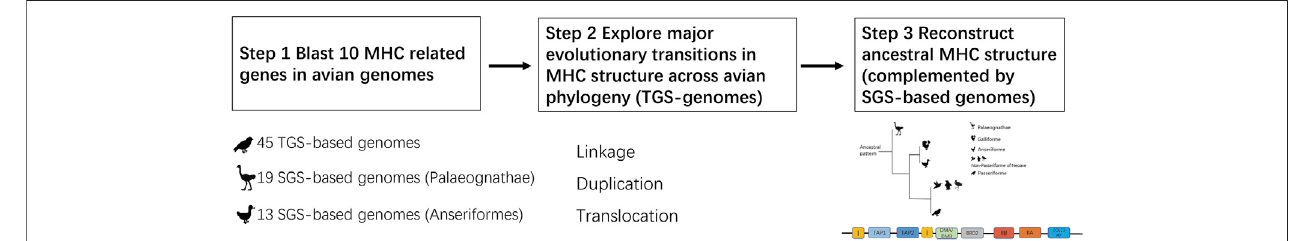
FIGURE 1 | The protocol used to reconstruct the evolution of avian MHC